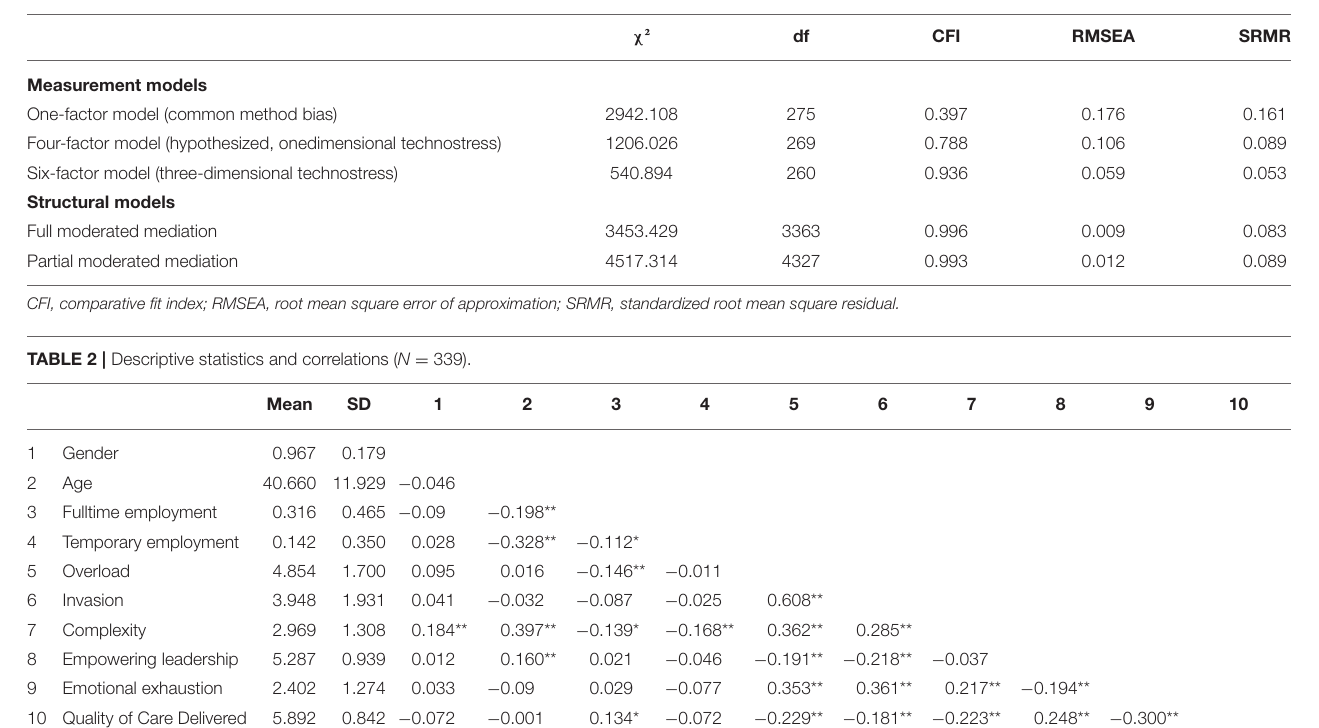
TABLE 1 | Models and fit indices. Measurement models